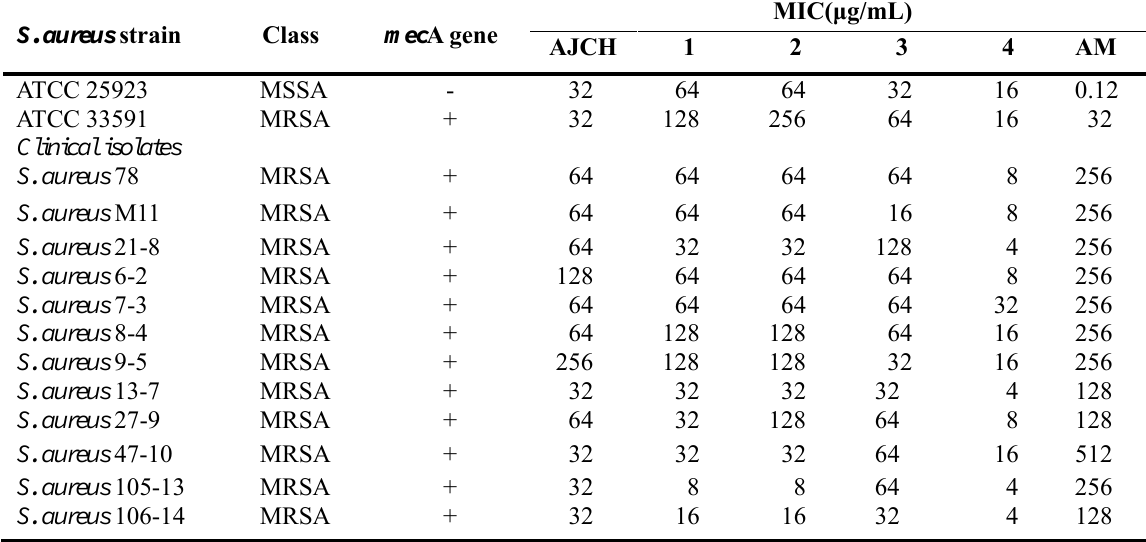
Table 2. The MICs/MBCs of A. japonica CHCl atractylenolide I ( 2 ), (6 E ,12 E )-tetradecadiene-8,10-diyne-1,3-diol diacetate ( 3 ) and (6 E ,12 E )-tetradecadiene-8,10-diyne-1,3-diol ( 4 ), and ampicillin (AM) against S. aureus